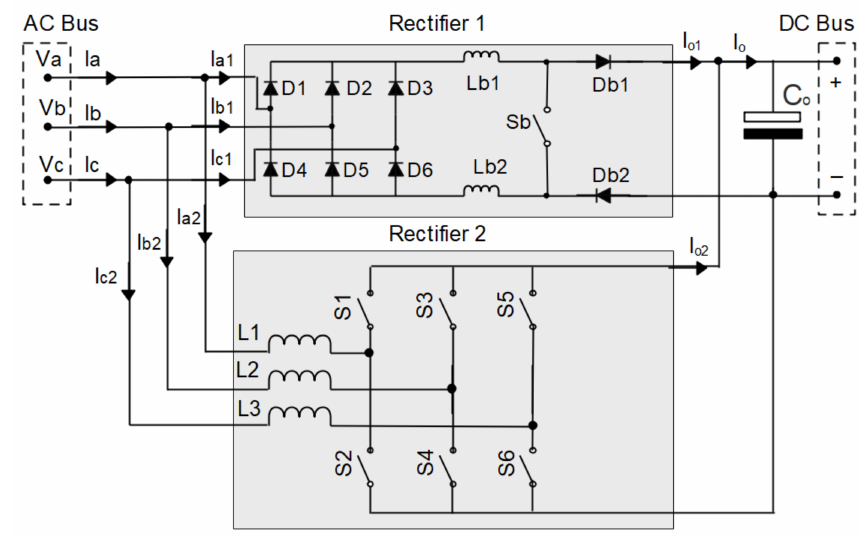
Figure 25. Configuration of the electrical circuit of BHTR-BR1//BR2.